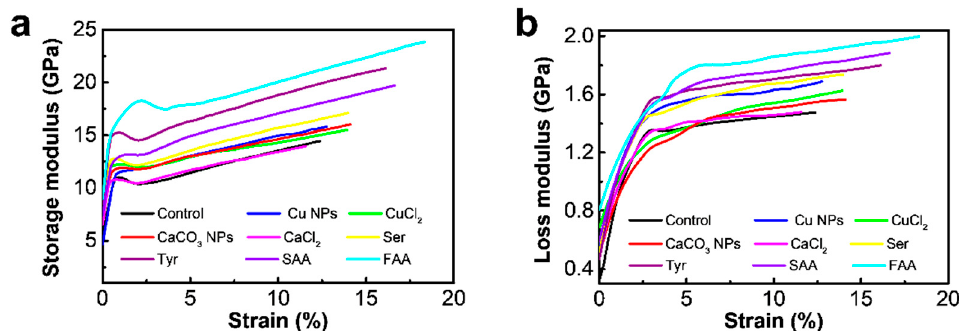
Figure 5. Continues dynamic analyses of silk fibers. ( a ) Typical storage modulus-strain curves. ( b ) Typical loss modulus-strain curves. (Ser = serine, Tyr = tyrosine, SAA = sericin amino acid, FAA = fibroin amino acid). Table 3. Continues dynamic analysis of silk fibers. Data are mean ± sd. Statistical analyses were